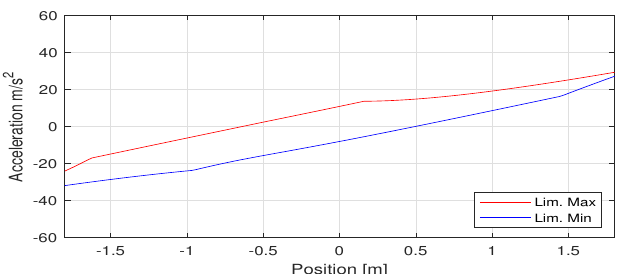
Figure 3. Maximum and minimum acceleration values along d